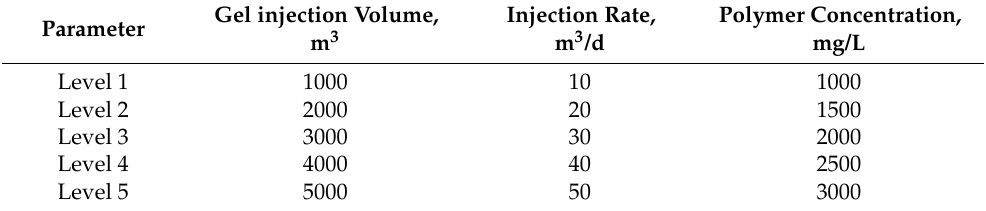
Figure 14. The history matching results of the typical single well.